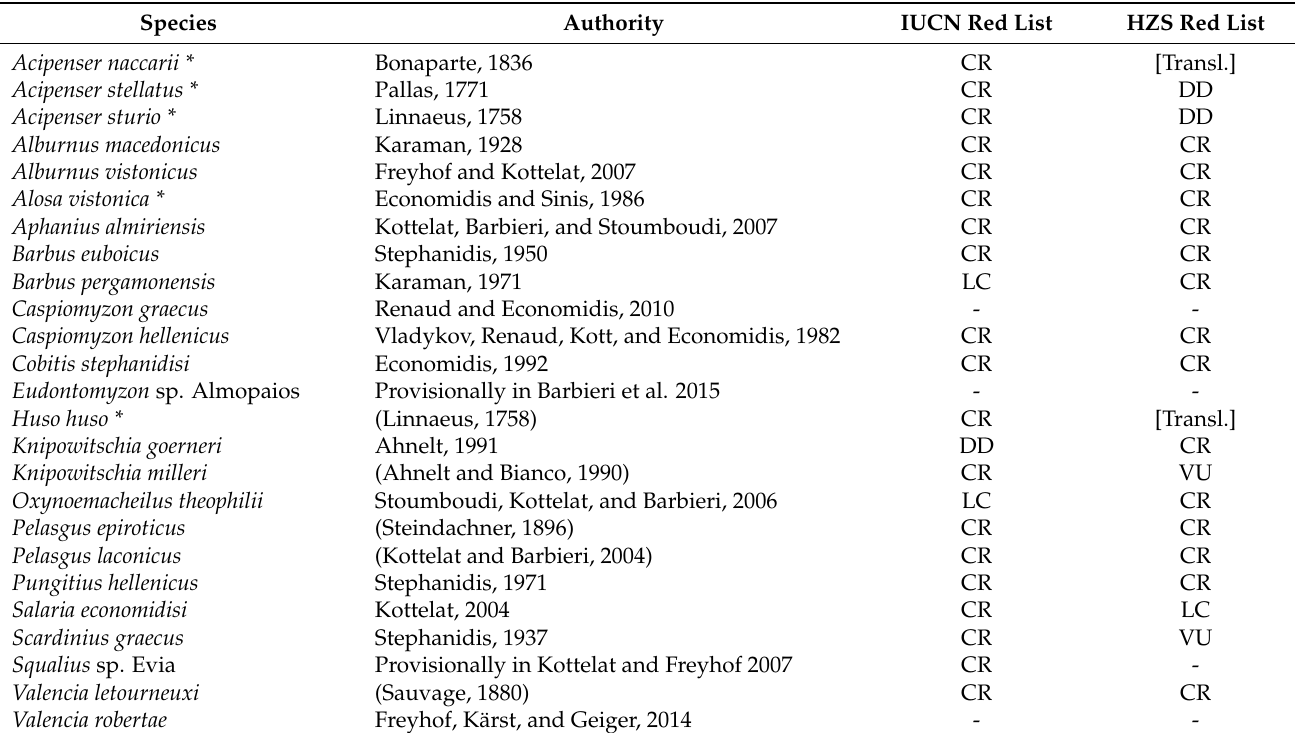
Table 1. Freshwater fish species of Greece listed as Critically Endangered (CR) under IUCN and/or the HZS Red Lists. Categories: CR, Critically Endangered; EN, Endangered; VU, Vulnerable; LC, Least Concern; and DD, Data Deficient. Transl. in brackets denotes species that are introduced as translocated populations, not the original wild stock. Species with an asterisk are currently presumed extirpated or extinct in